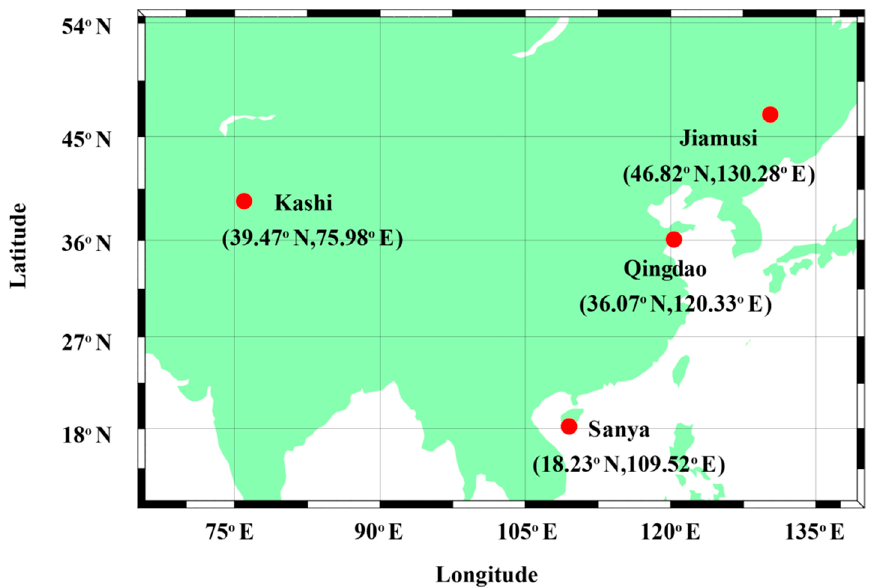
Figure 1. The distribution of radiosonde meteorological stations. Figure 1. the distribution of radiosonde meteorological stations.